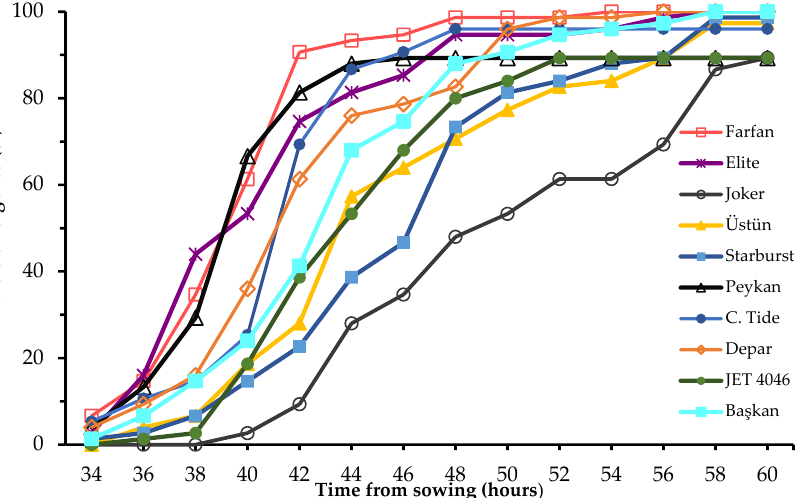
Horticulturae 2023 , 9 , x FOR PEER REVIEW Figure 2. Ten hybrid watermelon cultivars are making progress with the appearance of 2 mm radicles. The seed survival curves of ten watermelon cultivars are presented in Figure 3. The survival curves were produced by plotting normal germination percentages against the storage period (days). Some cultivars, such as Farfan, Peykan, and Elite, had higher val- ues during aging. All seed lots were dead by 63 days of storage. Ki probit values of the initial theoretical seed quality of each cultivar are shown in Table 2. Joker had the lowest Ki value, 1.22 ± 0.008, while Peykan had the highest, 2.53 ± 0.035. The rest were between these two. The longest seed storage longevity, as determined by P 50 , was seen in Farfan at 28.79 days, and the shortest one was seen in Joker at 17.17 days (Table 2). Even though they had very high normal germination percentages before storage (>98%), the difference in their longevity during storage was great. Farfan survived about 11 days more than Joker (Table 2), even though they had very similar germination percentages. Table 2. Probit model parameters for seed cultivars of ten hybrid watermelon seed cultivars aged with 17% seed moisture content over 63 days. Ki (s.e.) Cultivars